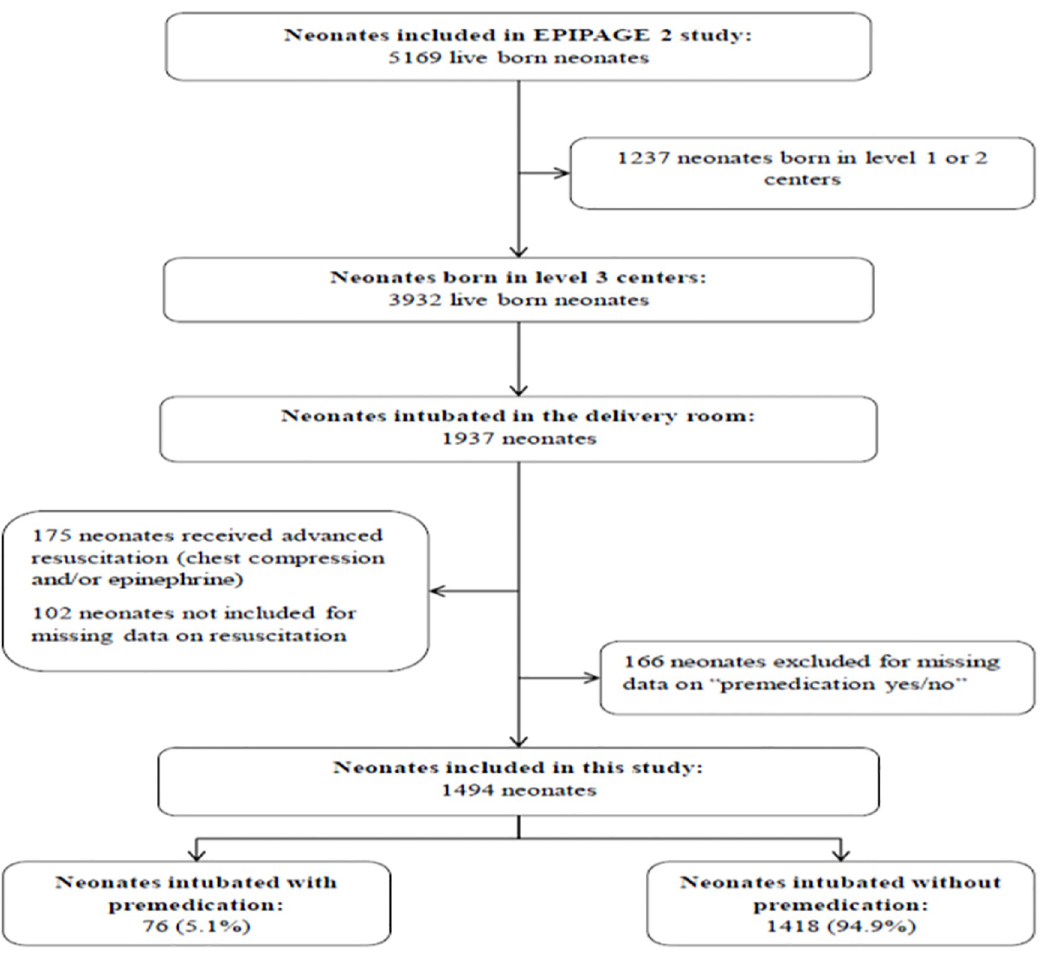
Fig 1. Population flow